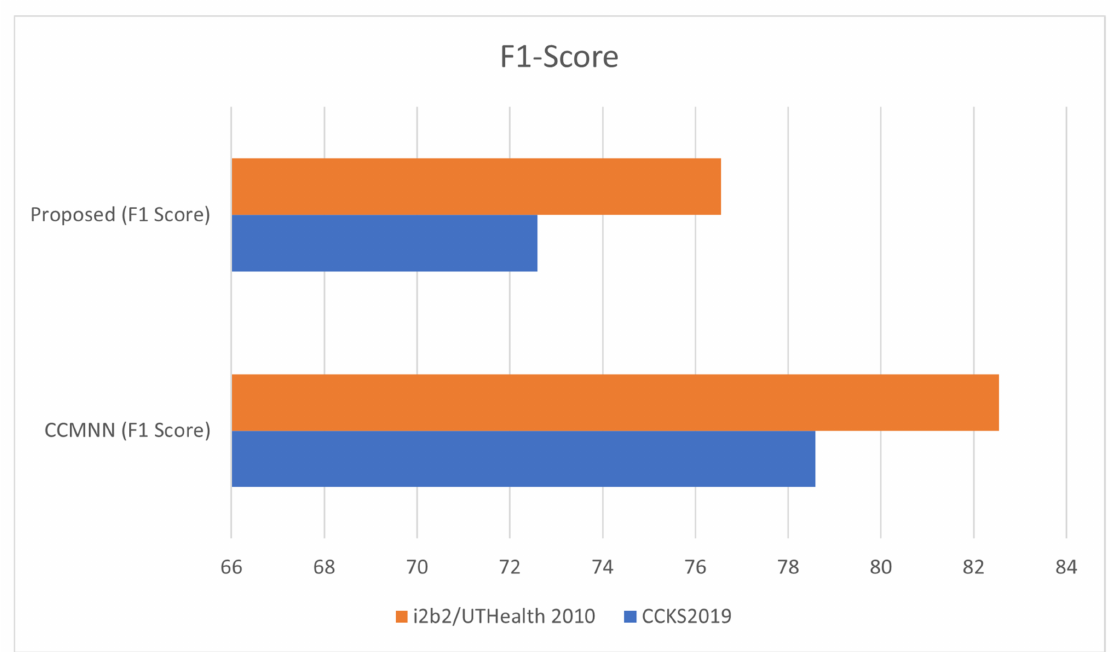
Figure 6. Evaluating Clinical Record Analysis Performance with F1 Score on the I2B2/UTHEALTH 2010 Dataset.